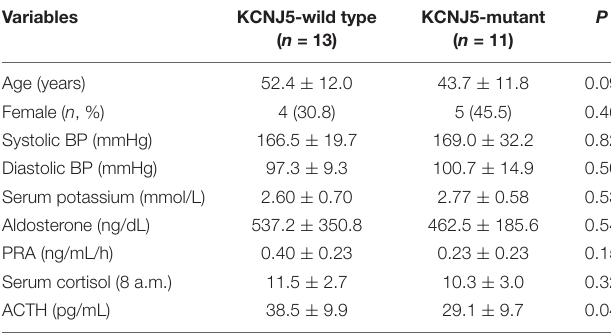
TABLE 1 | Clinical features of 24 patients with primary aldosteronism (PA).